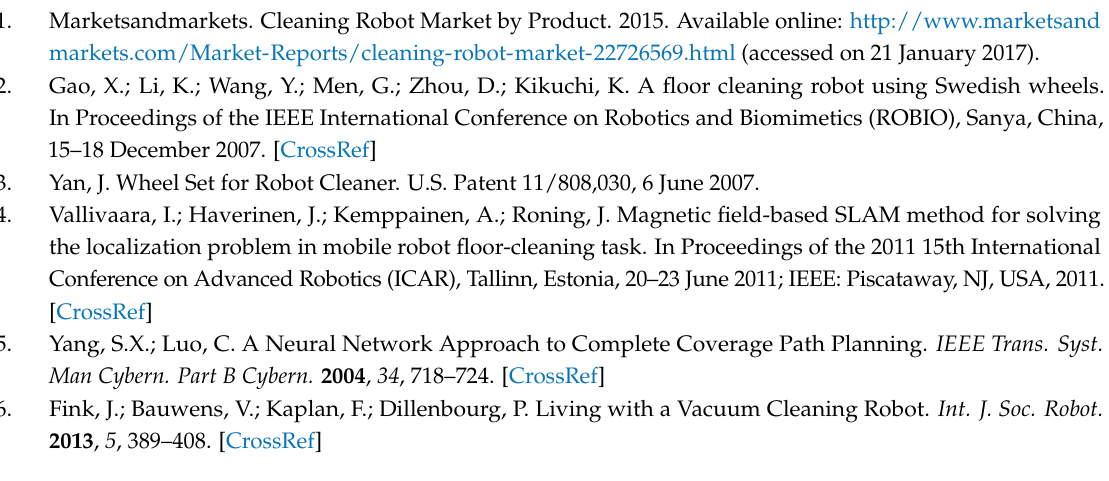
Figure 22. Tiling Process with Lemma 6 tile set.